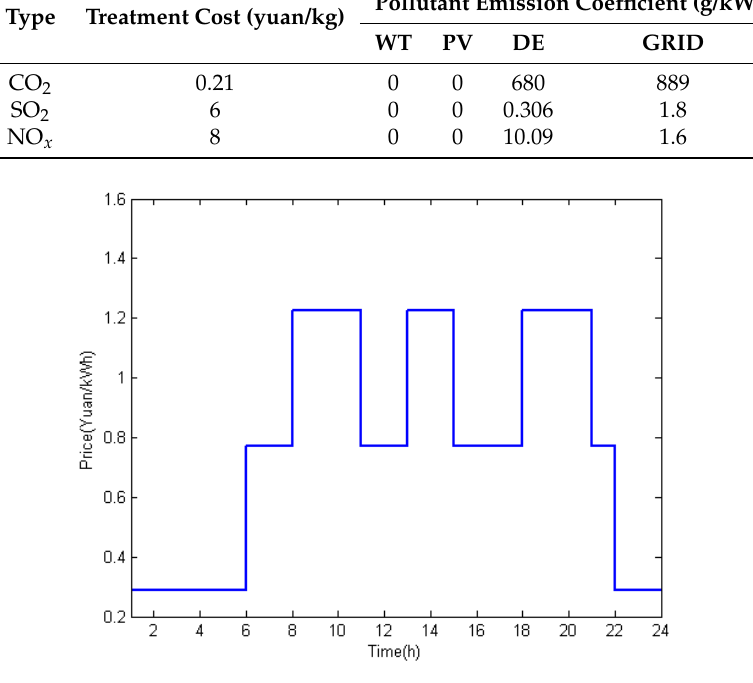
Figure 4. Time-of-use electricity prices.